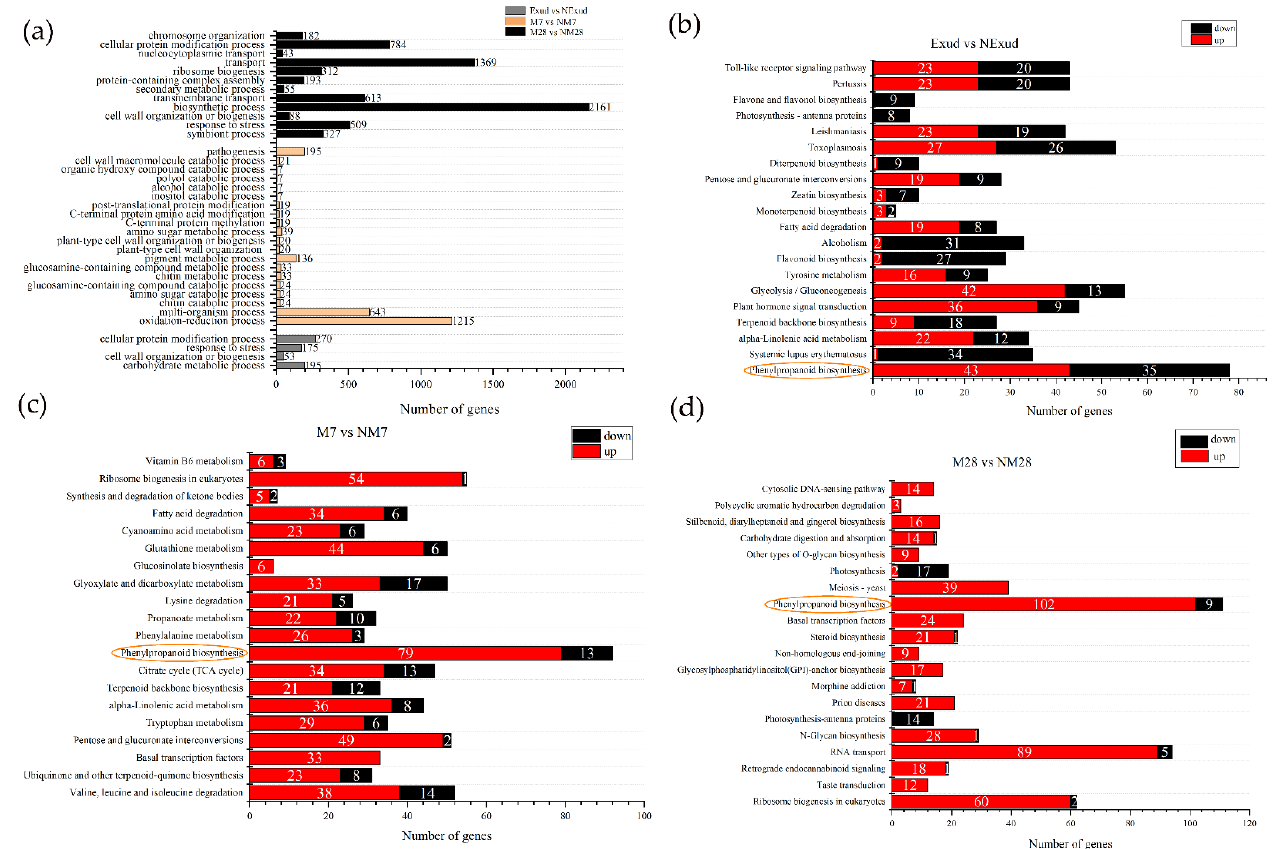
Figure 5. Enrichment of DEGs. ( a ) Enriched Gene Ontology biological processes. ( b – d ) Kyoto Encyclopedia of Genes and Genome enrichment for Exud vs. NExud, M7 vs. NM7, and M28 vs. NM28. The numbers shown on the red and black bars indicate the number of upregulated and downregulated DEGs, respectively. The phenylpropanoid biosynthesis pathway (circled) was common to all three symbiosis stages.